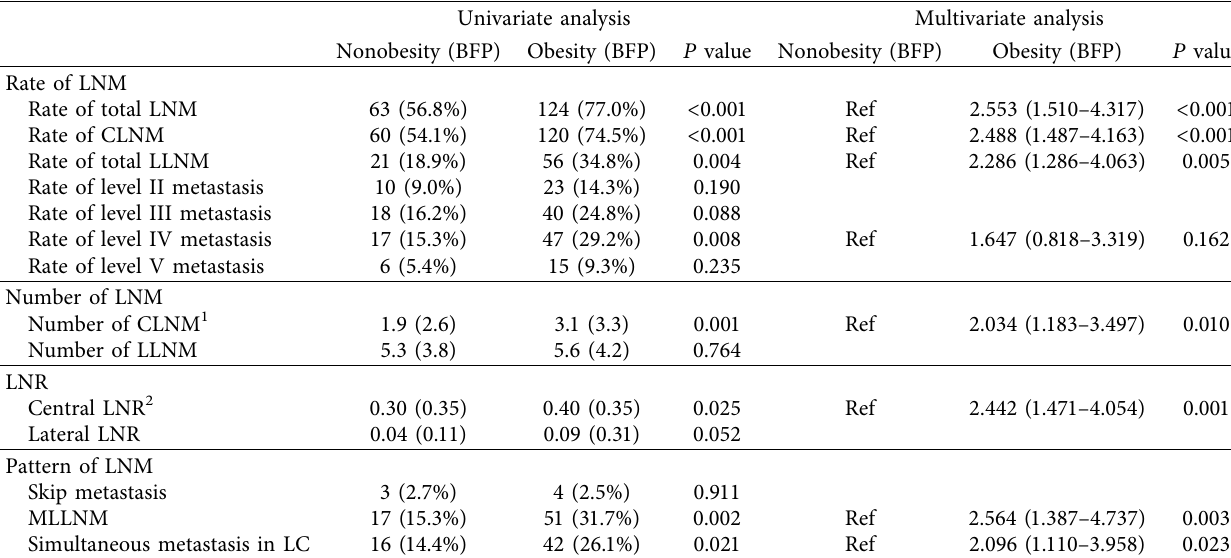
Table 3: Relationship between BFP and diferent regional lymph node involvement in men.